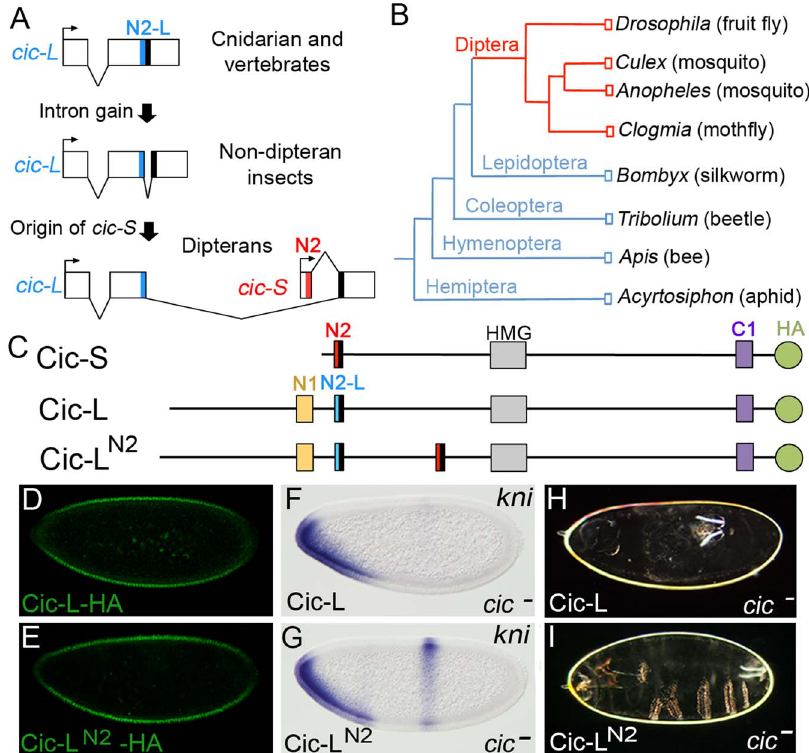
Fig. 6. Recent origin of the N2 motif in dipterans. (A) Schematic representation of proposed steps giving rise to the Cic-S isoform and the N2 motif. The diagrams show the regions spanning the alternatively spliced exons of cic-S and cic-L transcripts in selected species, which are represented graphically and are not drawn to scale. The size of introns splitting the N2-L coding sequences in non-dipteran species are as follows: Bombyx mori (758 bp), Tribolium castaneum (50 bp), Apis mellifera (86 bp) and Acyrthosiphon pisum (129 bp) (see also main text). The conserved protein motifs encoded at relevant exon junctions are shaded in red, blue or black as in Fig. 3. (B) Insect phylogeny illustrating the presence of the Cic-S and N2 motifs in dipterans (red). (C) Diagram of the Cic-S, Cic-L and Cic-L N2 proteins; Cic-L N2 carries the N2 motif inserted within a poorly conserved sequence of Cic. Cic-L and Cic-L N2 were expressed with an HA tag at the C-terminus. (D and E) Expression of HA-tagged Cic-L (D) and Cic-L N2 (E) proteins in embryos stained with anti-HA antibody. (F and G) mRNA expression patterns of kni in cic 1 /cic Q474X mutant embryos expressing Cic-L (F) and Cic-L N2 (G); only Cic-L N2 leads to significant rescue of the central kni stripe. (H and I) Cuticle phenotypes of the same genetic backgrounds shown in F and G, respectively.